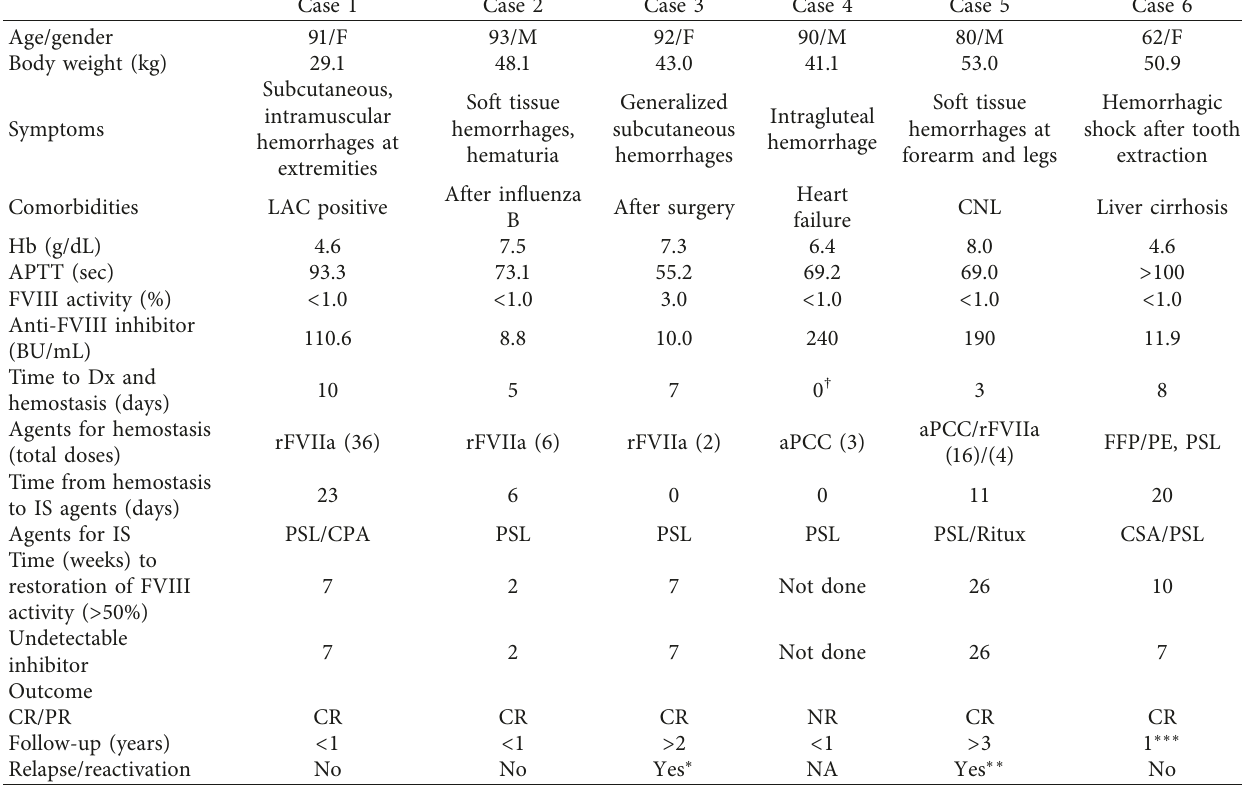
Table 1: Clinical features of 6 elderly cases with